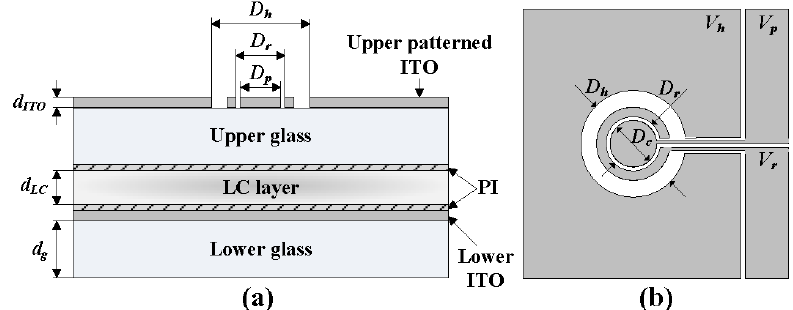
Figure 1. (a) Side-view of the ring-and-pie LC lens structure. (b) Top